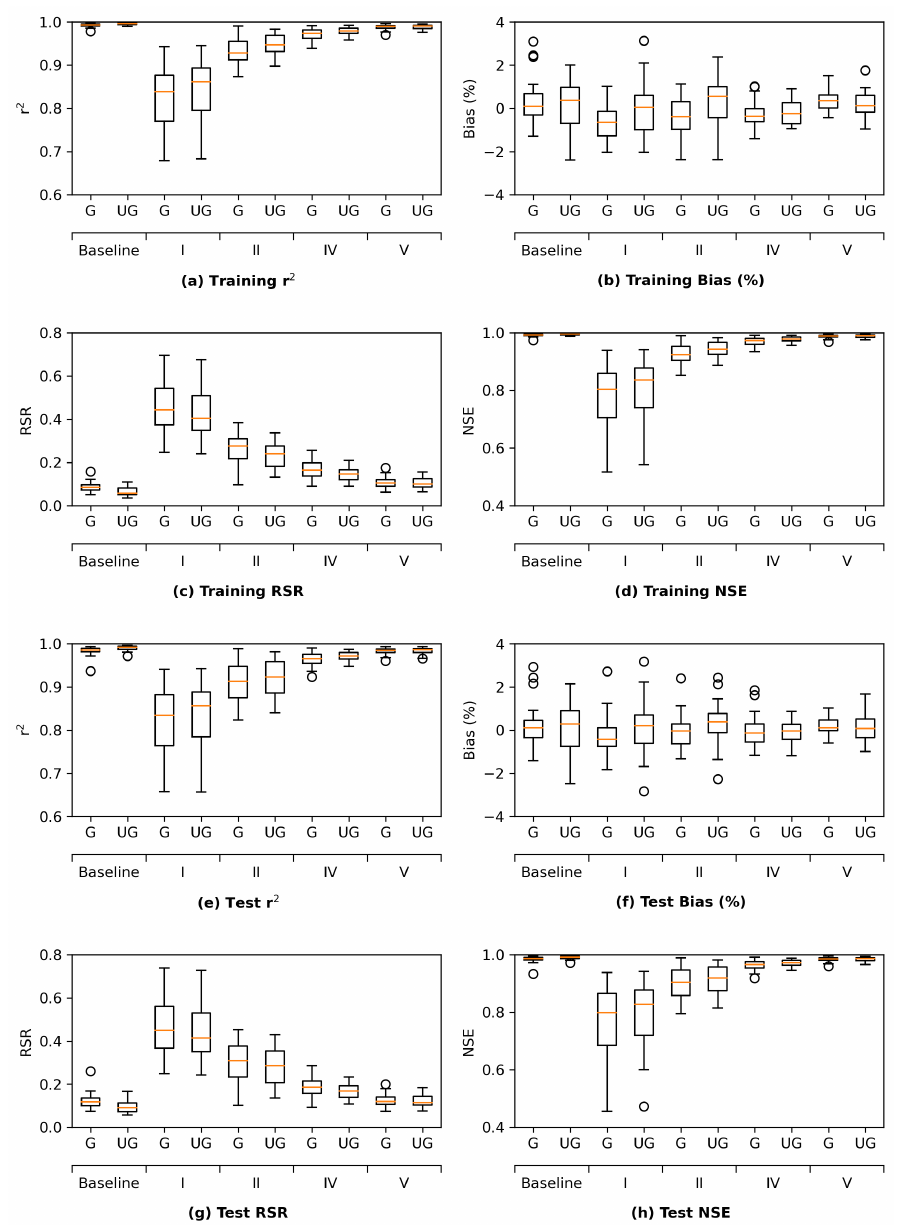
Figure 7. Box and whisker plots of four types of metrics consisting of r 2 , percent bias, RSR, and NSE during the training (panels ( a – d )) and test (panels ( e – h )) phases of the grouped (G) and ungrouped (UG) LSTM models under five scenarios: baseline and four different memory lengths as presented